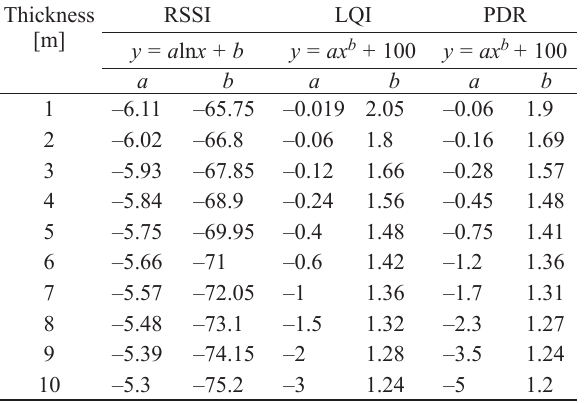
Table 3. Empirical equations for steel plate ( x denotes T-R separation distance) Thickness RSSI [m]